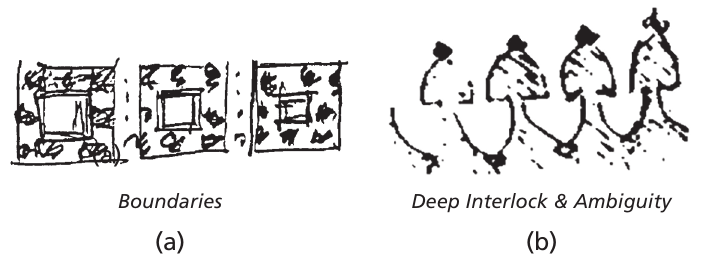
Figure 15. ( a ) boundaries; ( b ) deep interlock and ambiguity. Source: { Nature of Order Book One} [6].